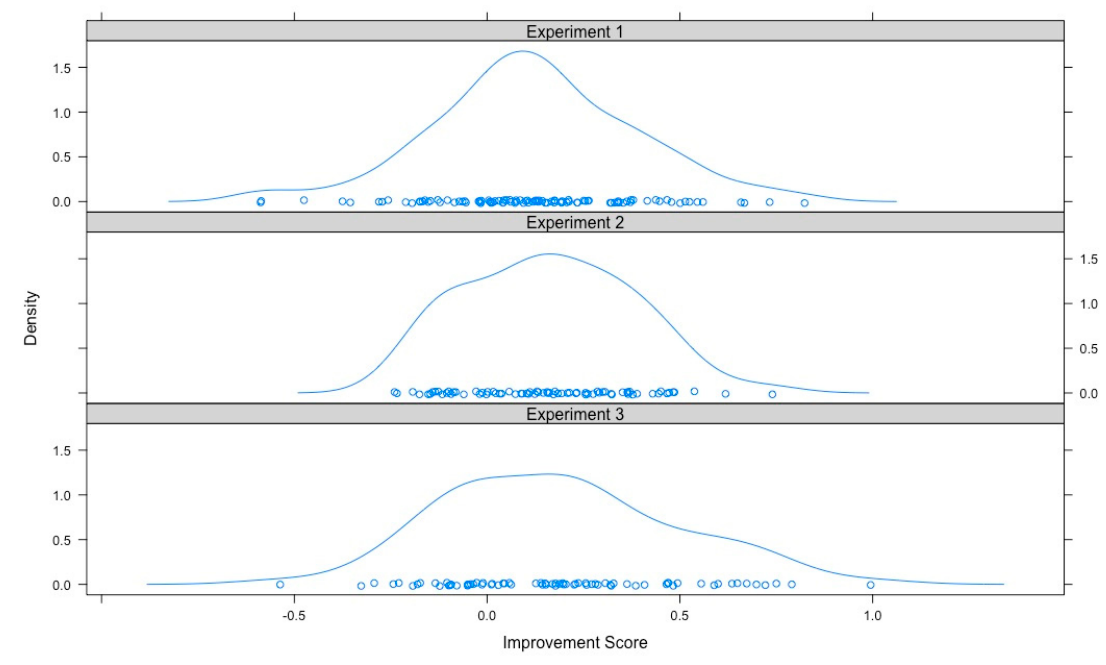
Figure 5. Density plots for improvement on the second training set for Experiments 1, 2 and 3. Pairwise Kolmogorov-Smirnov tests showed that the distributions were not statistically different from each other (minimum p = 0.41) and one-way ANOVA showed that the means of the improvement scores were not statistically different from each other, F (2, 244) = 1.37, p = 0.26.